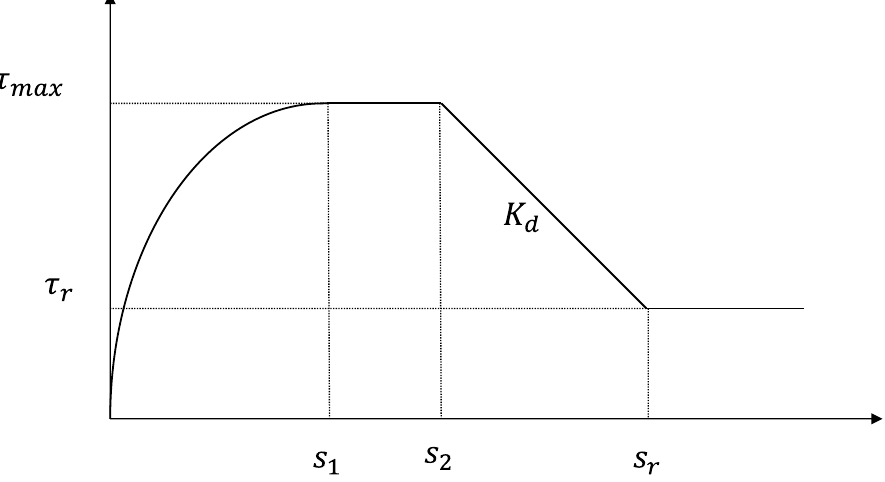
Figure 13. BPE model of the bond–slip curve for the steel rebar. Table 6. Parameters for the ascending parts of existing models.